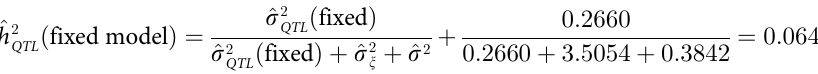
Table 1. Estimated parameters of trait KGW from the fixed and random models for bin 725 of the rice population ( s 2 Parameter Fixed model Random